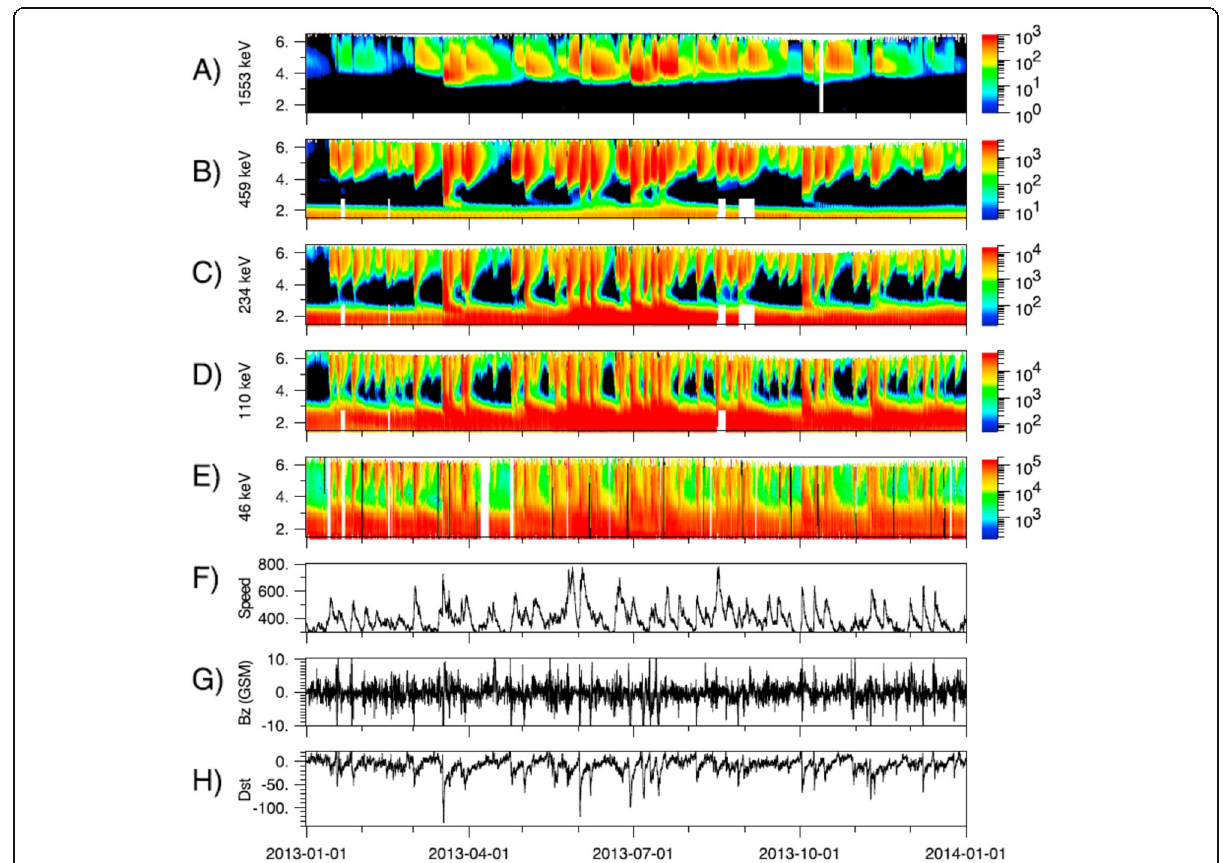
Fig. 11 A multi-energy view of flux as a function of L shell (distance from the Earth in unit of Earth radius) and time from the Van Allen Probes mission for 2013. a – d Background-corrected electron fluxes measured by MagEIS, e electron fluxes measured by HOPE, f solar wind speed, g IMF Bz, and g Dst index. Clear differences can be seen in radiation belt electron behavior at different energies and from event to event (taken from Reeves et al.